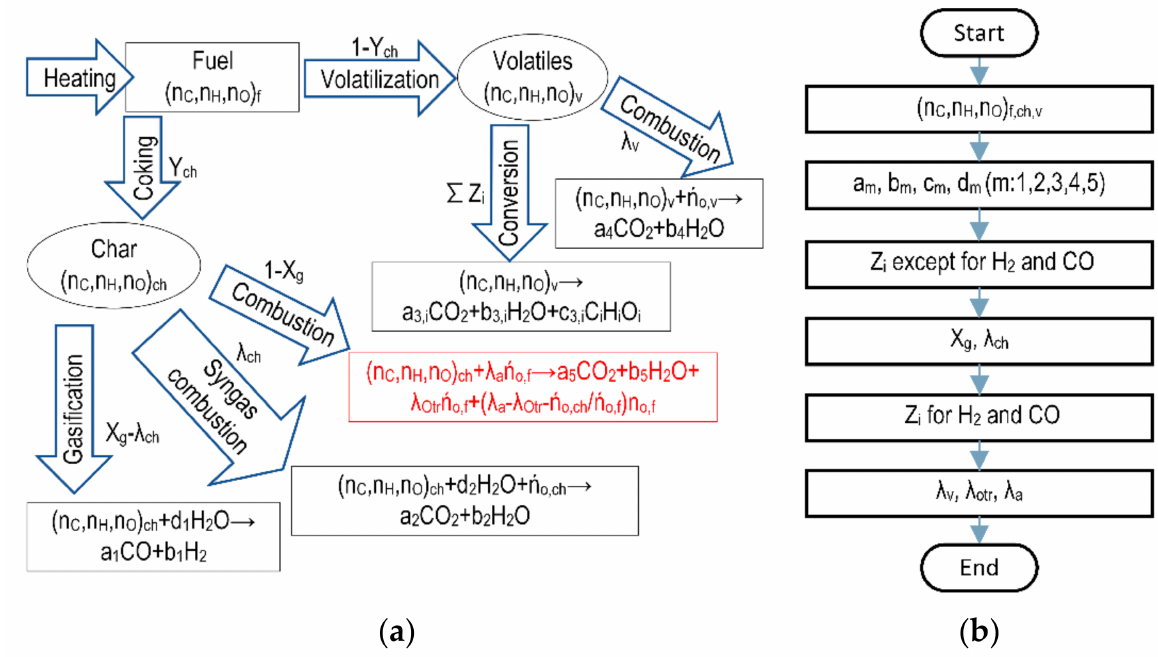
Figure 2. Pyrolysis process and chemical reactions of biomass gasification in dual fluidized bed and flow chart for calculating mass balance in them. ( a ) Pyrolysis process and chemical reactions; ( b ) flow chart for calculating mass balance. ( ( n x ) y : molar yield of element x (C: carbon; H: hydrogen; O: oxygen) in related substance y (f: biomass; v: volatiles; ch: char); Y ch : char yield; X g : fraction of char gasified; λ ch : fraction of char gasified and then combusted; λ v : fraction of volatiles combusted; Z i : fraction of volatiles converted to raw gas compound i (H 2 , CO, CH 4 , C 2 H 2 , C 2 H 4 , C 2 H 6 , tar, BTX (benzene, toluene and xylene), etc.); a m , b m , c m , d m : stoichiometric coefficients of chemical reaction m (1: char gasification; 2: